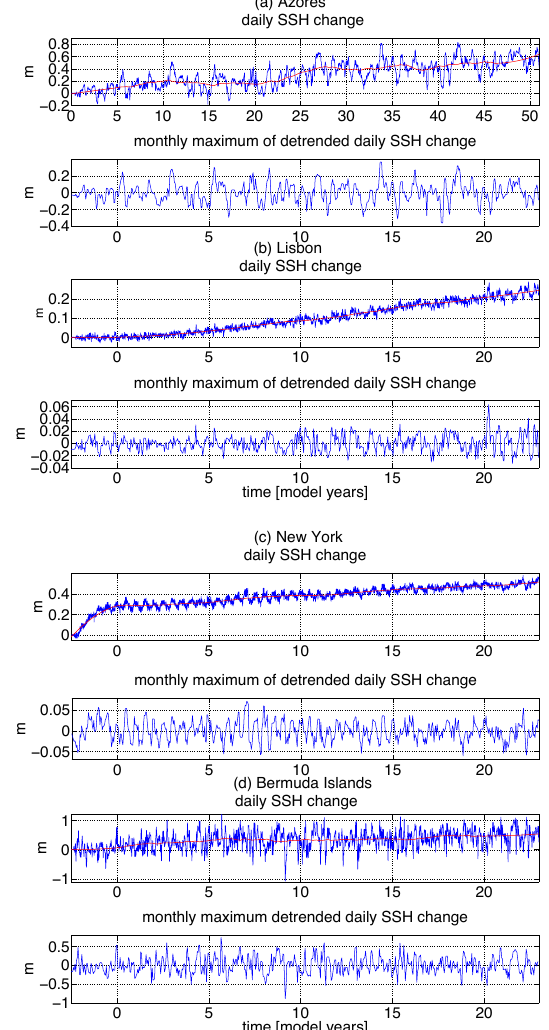
Fig. 9. (a-d) Monthly maximum values of daily SSHP change at a coastal location (blue) with its long term signal (red) and the monthly maximum of the high pass filtered (detrended) daily mean SSHP change. The locations considered are (a): Azores, (b): Lisbon, (c): New York and (d): Bermuda Islands.